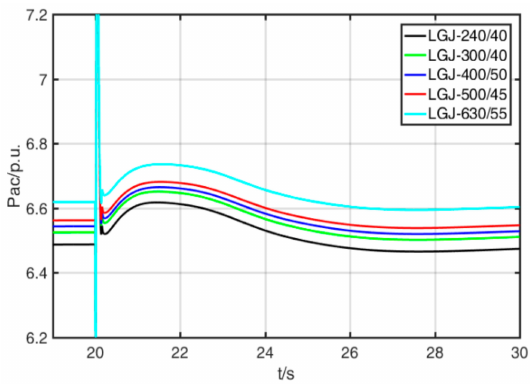
Figure 8. Power oscillations of the AC tie-line with di ff erent types of transmission lines. Table 3. Parameters a ff ecting the power oscillations of di ff erent types of transmission lines.